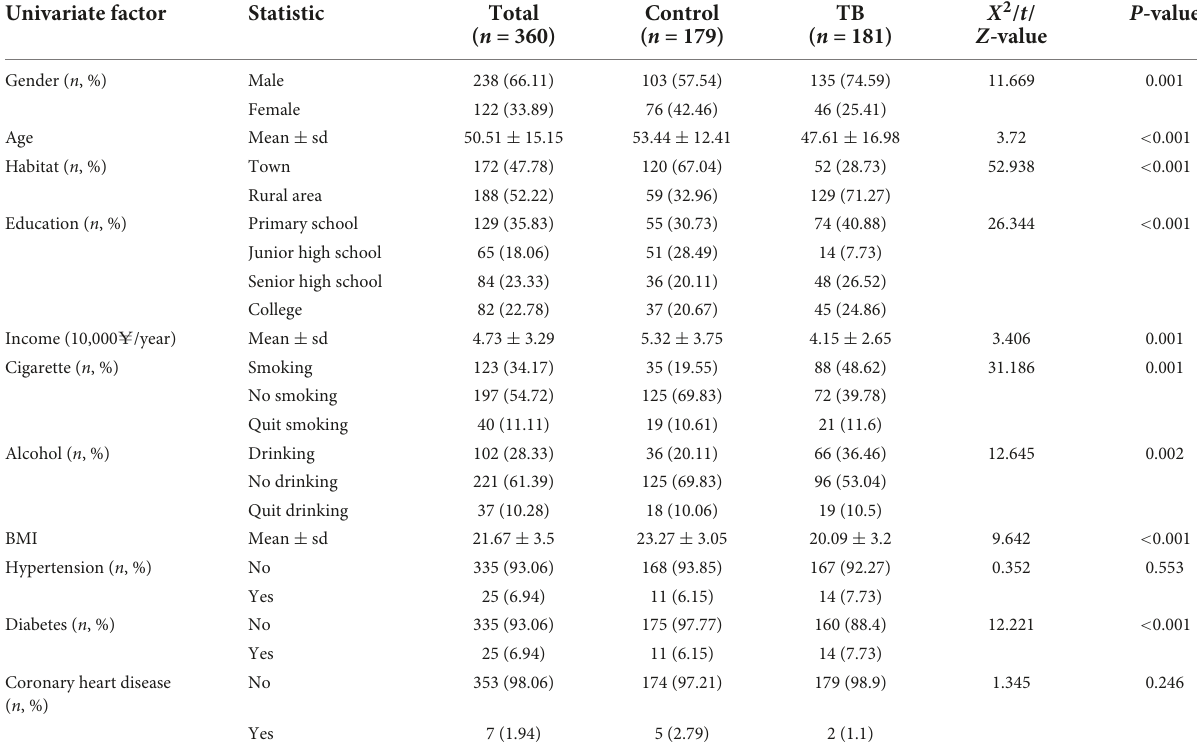
TABLE 1 General information of the case control study ( N = 360). Univariate